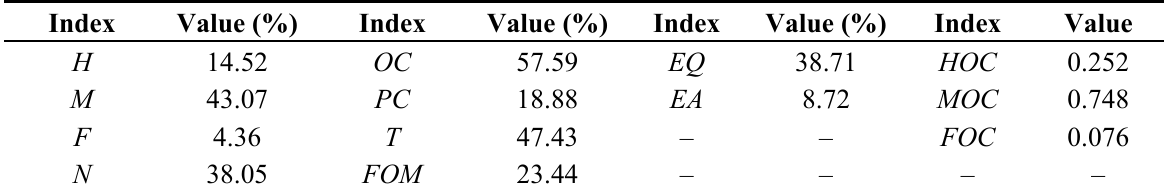
Figure 8. Prediction correctness and error based on 1954 (reference), 1932 (reference) and 1932 (simulated) land-use maps. Table 4. Validation results of the three-map